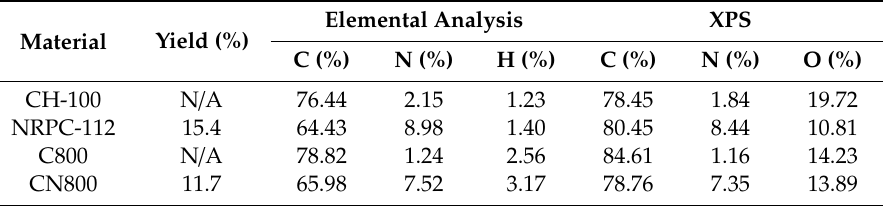
Table 1. Yields, elemental analysis, X-ray photoelectron spectroscopy (XPS) analysis of the C800 and CN800. Elemental Analysis XPS Material Yield (%) C (%) N (%) H